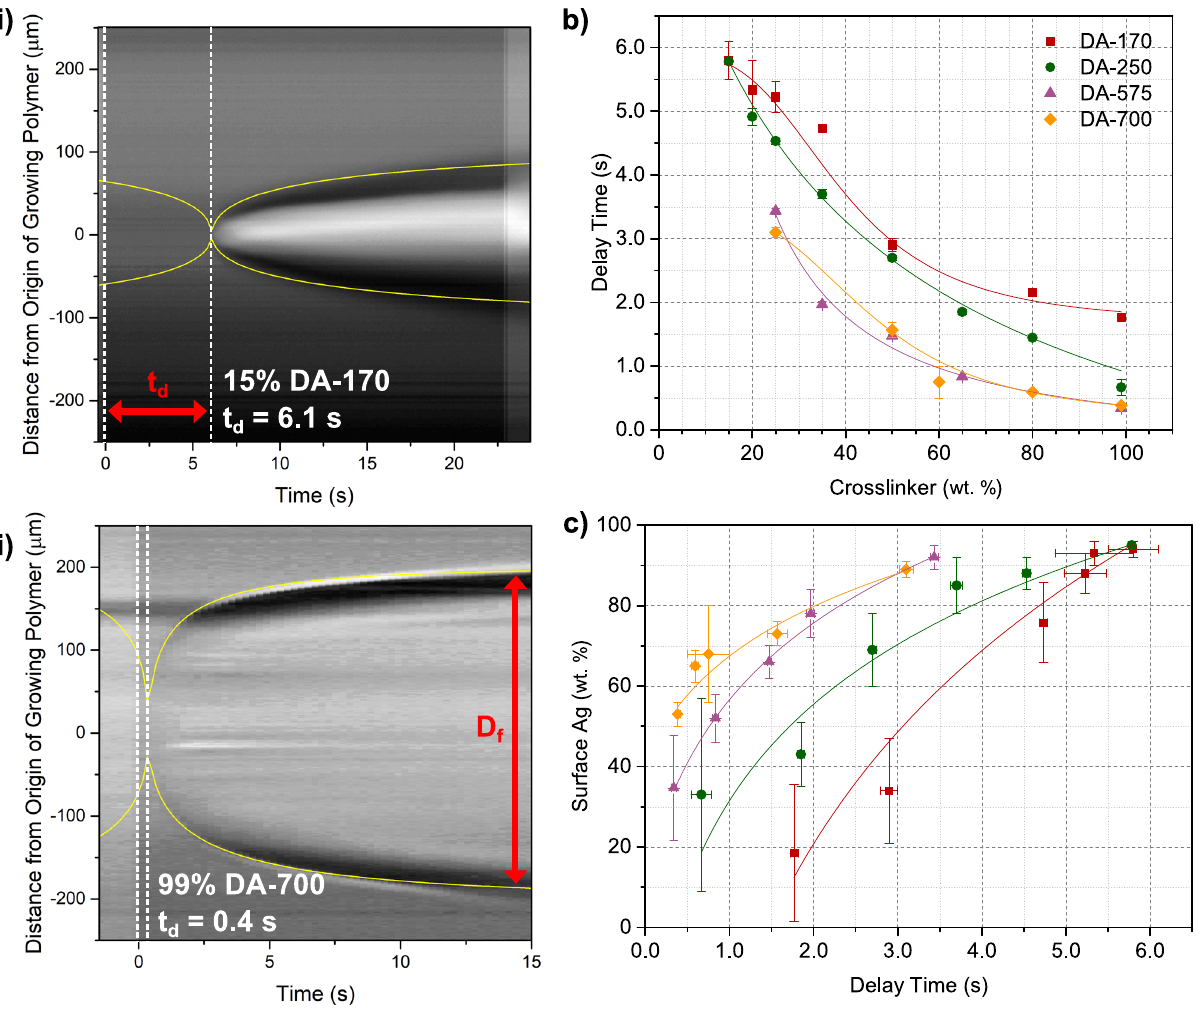
Fig. 3 Dynamical study of photoresins by optical microscopy. a Constructed images obtained from movies of islands of polymer formed when resin/ crosslinker inside a capillary is exposed to a focused 405 nm laser spot. A slice through the center of the island reveals its two opposite edges and is plotted as function of time. Two examples (i) and (ii) are shown for 15 wt. % DA-170 and 99 wt .% DA-700. b Delay time, t d , extracted from a fi t to Eq. 1 (See Experimental Section) as a function of wt. % crosslinker. c Weight % of Ag extracted from SEM/EDS analysis at the surface of the cylinder as a function of t d for various resin formulations. The delay times are from the same gelation experiments exposed to a 405 nm laser in part a , b for each